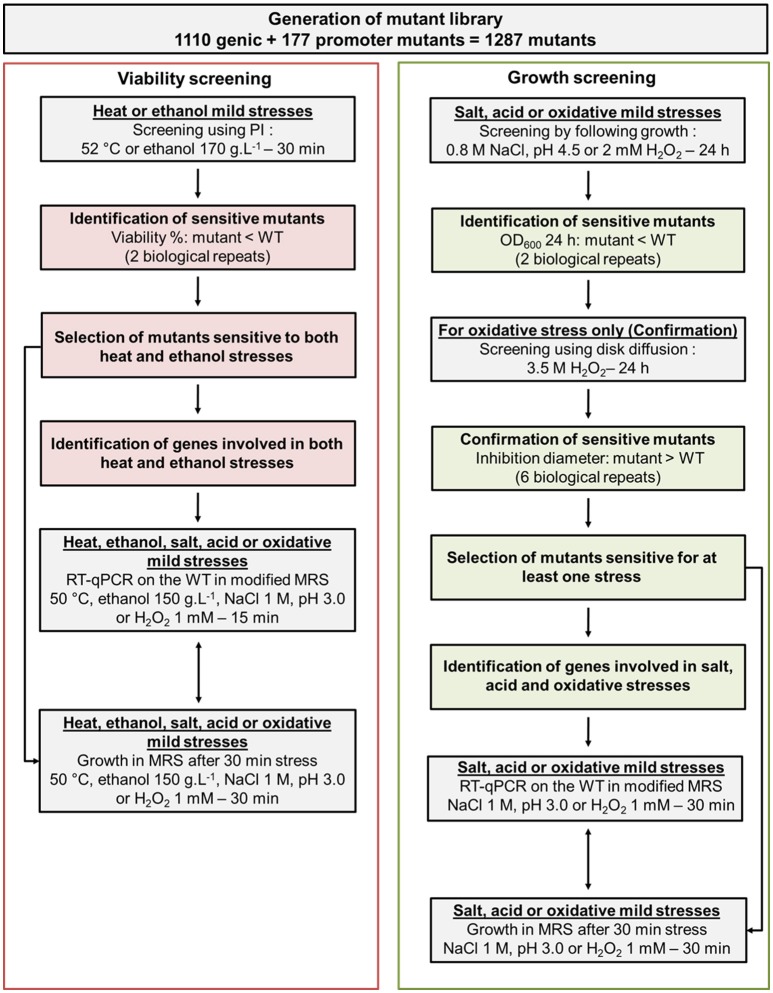
Organizational chart of the screening strategy to identify genetic factors involved in L. paracasei response to five monofactorial mild stresses: heat, ethanol, salt, acid, and oxidative.